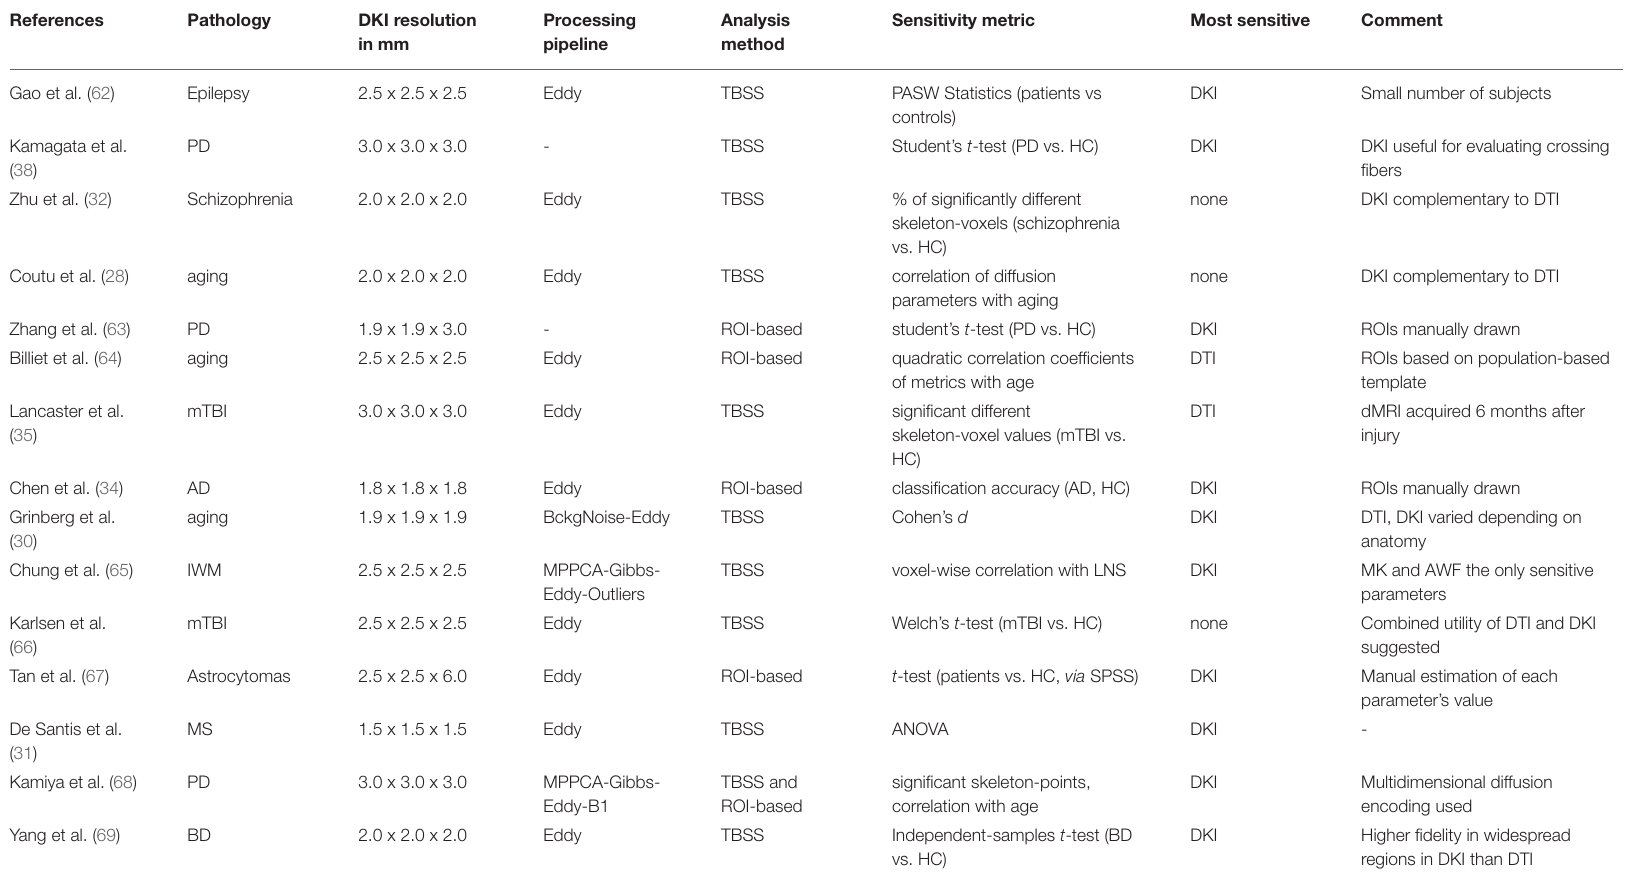
TABLE 3 | Overview of studies comparing 3T-DTI to